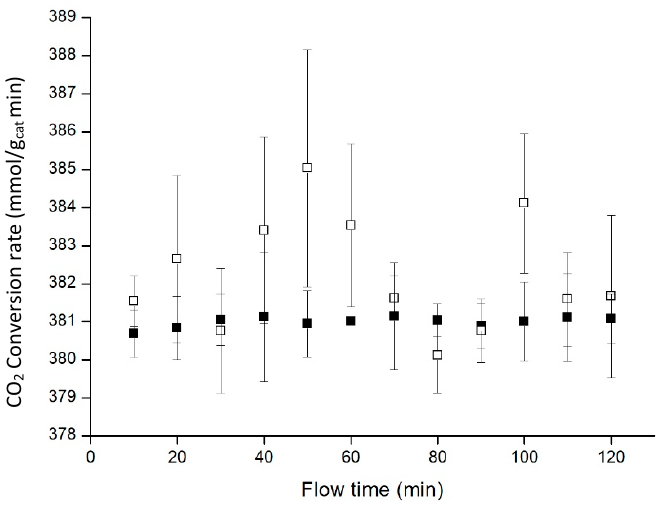
Figure 10. Influence of the reactants proportion (H 2 :CO 2 3:1 ■ , 4:1 □ ). Data points represent the average of 3 experiments, with error bars corresponding to confidence interval 95%.